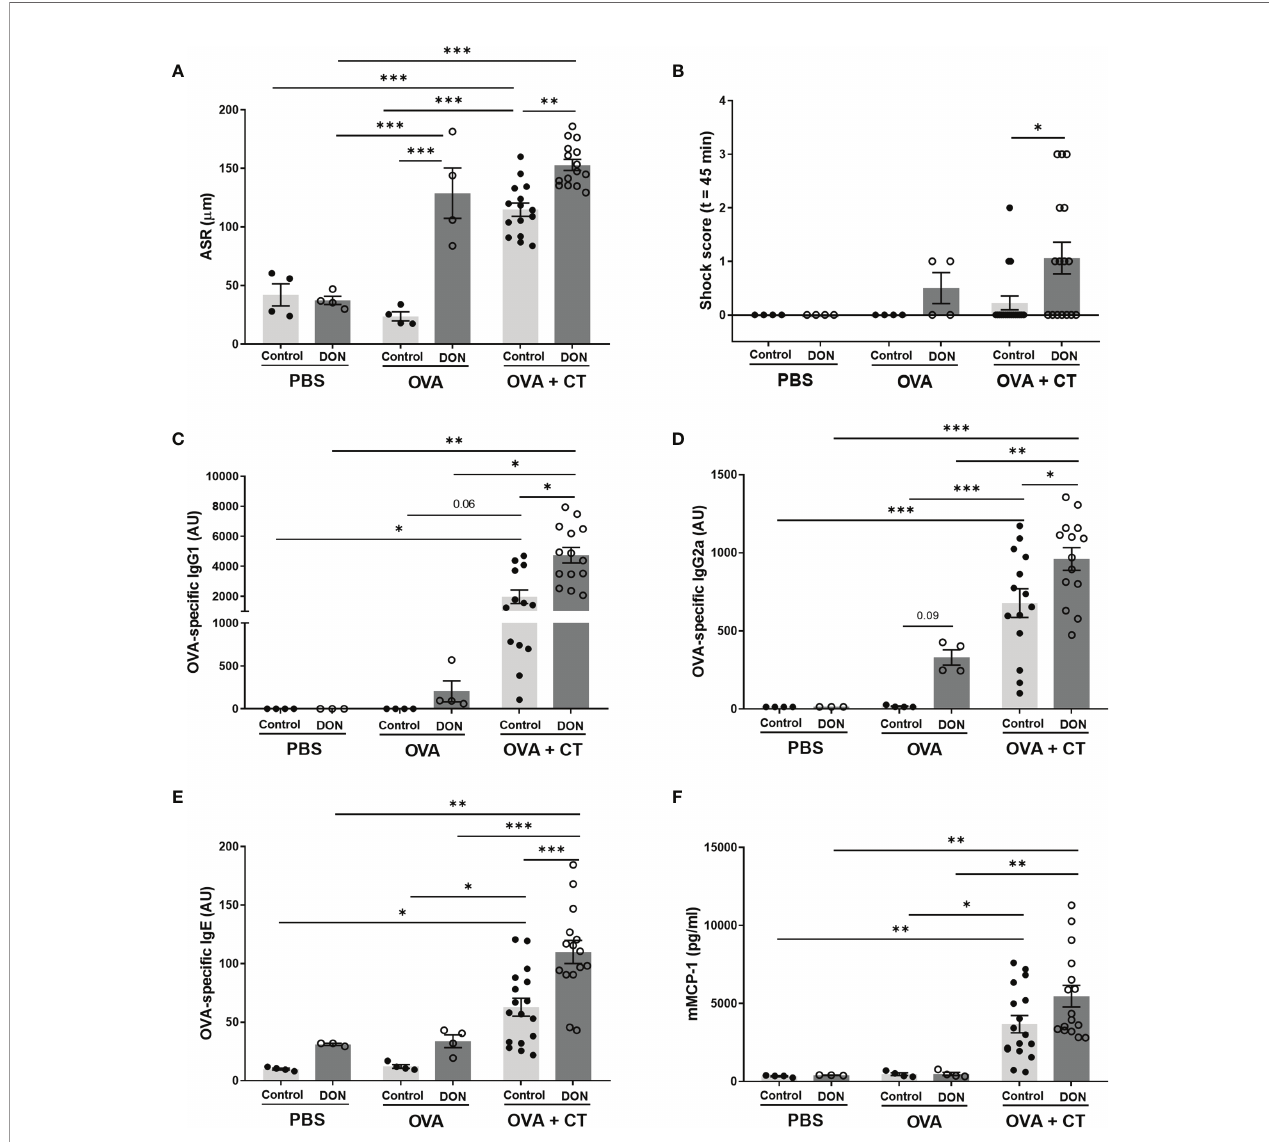
FIGURE 2 | Maternal deoxynivalenol (DON) exposure enhanced ovalbumin (OVA)-speci fi c allergic response and serum immunoglobulins (Ig) in the female offspring. Pregnant mice fed either a control or DON-contaminated diet (12.5 mg/kg) during pregnancy and lactation period. Female offspring received oral sensitizations with either phosphate-buffered saline (PBS), OVA, or OVA with cholera toxin (CT) after weaning. A week after the last sensitization, (A) OVA-speci fi c acute allergic skin response (ASR), measured as changes in ear thickness 1 hour after intradermal challenge; and (B) accompanying anaphylactic shock score was determined 45 minutes after intradermal challenge with OVA. Serum levels of (C) OVA-speci fi c IgG1, (D) IgG2a, (E) IgE, and (F) murine Mast cell protease-1 (mMCP-1) were measured 15 hours after oral gavage with ovalbumin. Data are presented as mean ± SEM. *p < 0.05, **p < 0.01 and ***p < 0.001 indicate statistical